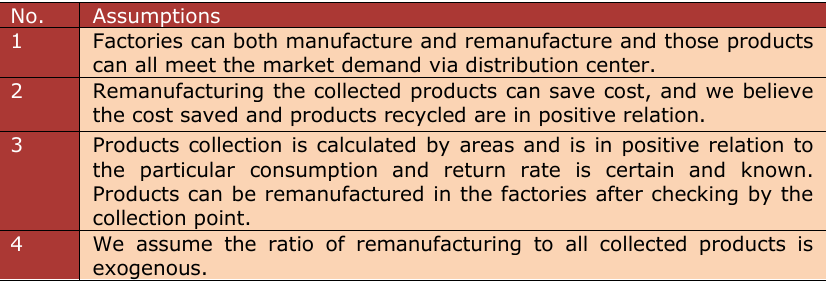
Table 1. Assumed conditions of the